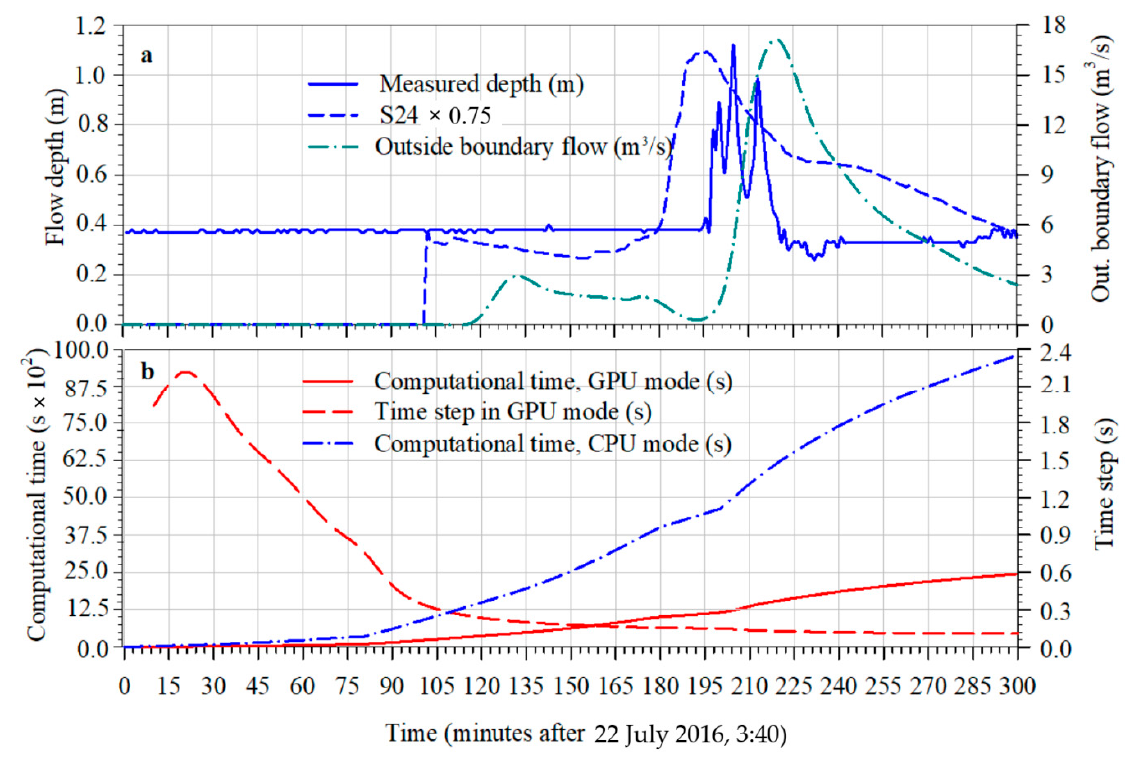
Figure 9. Simulation S24: ( a ) numerical flow depth at station P1 and outside-boundary water flow; ( b ) Computational time in CPU and GPU modes and GPU time step values.